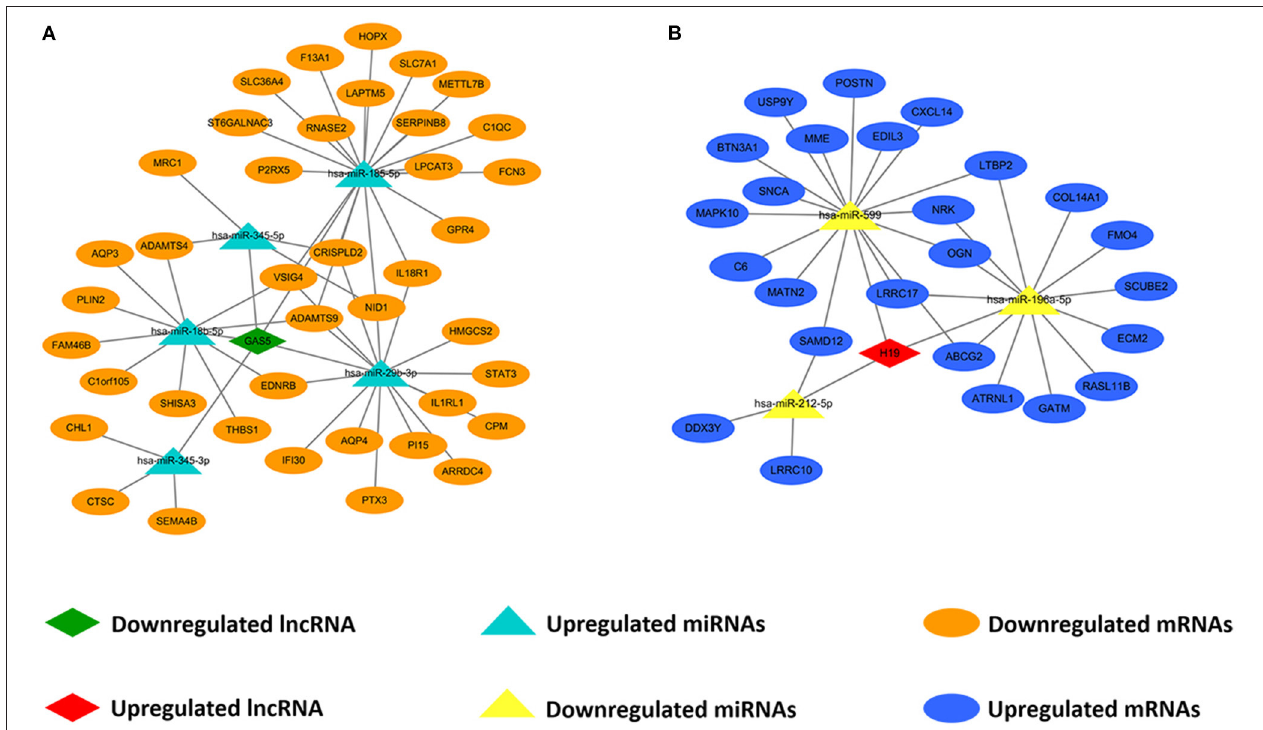
FIGURE 3 | Construction of lncRNA-mediated ceRNA regulatory network. (A) The lncRNA-mediated downregulated ceRNA network; (B) The lncRNA-mediated upregulated ceRNA network. Green means downregulated LncRNA, red means upregulated LncRNA, blue indicates upregulated miRNAs and mRNAs, yellow represents downregulated miRNAs, orange represents downregulated